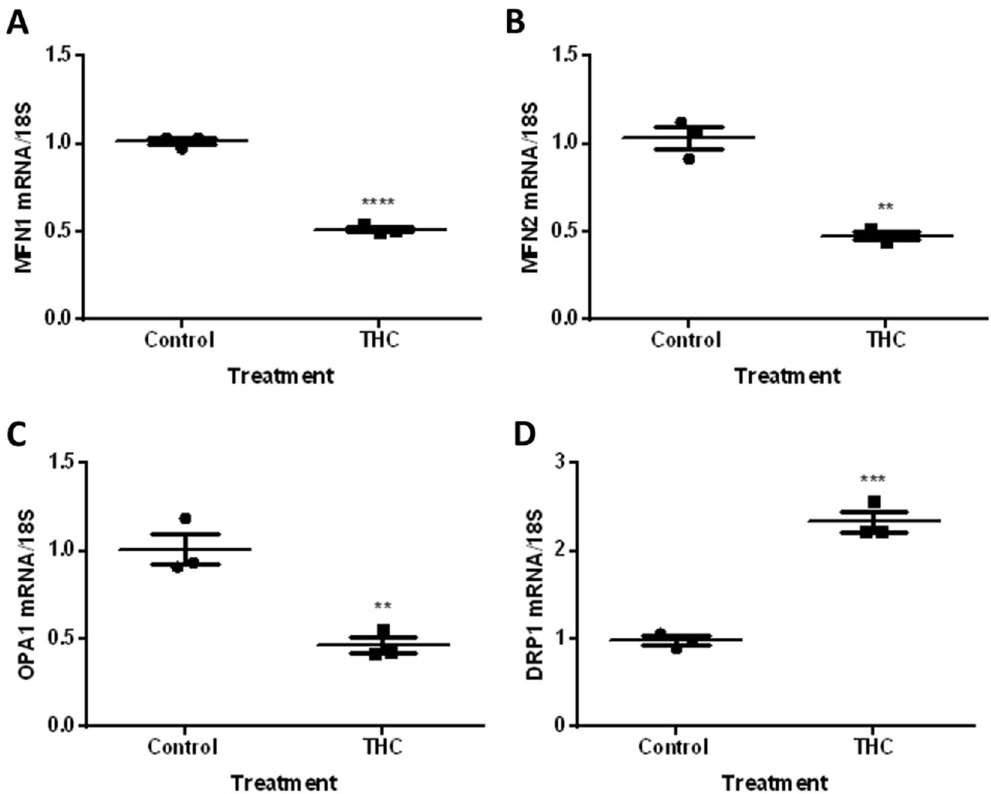
Figure 4. Mitochondrial fusion and fission transcripts are altered in response to 20 µM THC in HTR8/SVneo cells. Summary histograms are shown of relative MFN1 (A) , MFN2 (B) OPA1 (C) and DRP1 (D) transcript expression in each treatment group following 48 h of THC treatment which were normalized to 18S, then compared to the gene in the vehicle control group. Significant differences were determined by Student’s t-test. Individual data points are presented, the mean represented by the horizontal lines ± SEM (n = 3). **** P < 0.0001 (A) , ** P < 0.01 (B,C) , *** P < 0.001 (D)